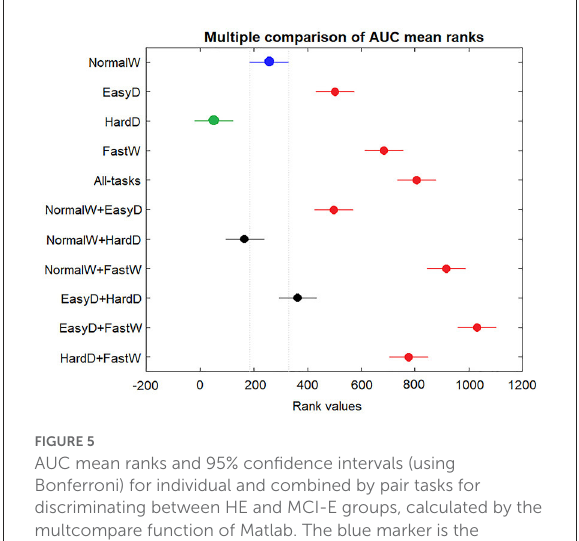
FIGURE5 AUC mean ranks and 95% confidence intervals (using Bonferroni) for individual and combined by pair tasks for discriminating between HE and MCI-E groups, calculated by the multcompare function of Matlab. The blue marker is the reference task, black dot indicates no significant differences regarding to the reference, red dots mean more significant differences from the reference, and green ones, less significant